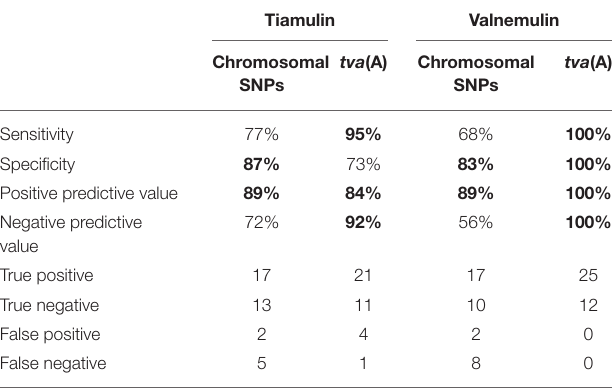
TABLE 2 | Reduced tiamulin and valnemulin susceptibility predicted by genome sequence based on the presence of mutations in chromosomal genes or the presence of tva